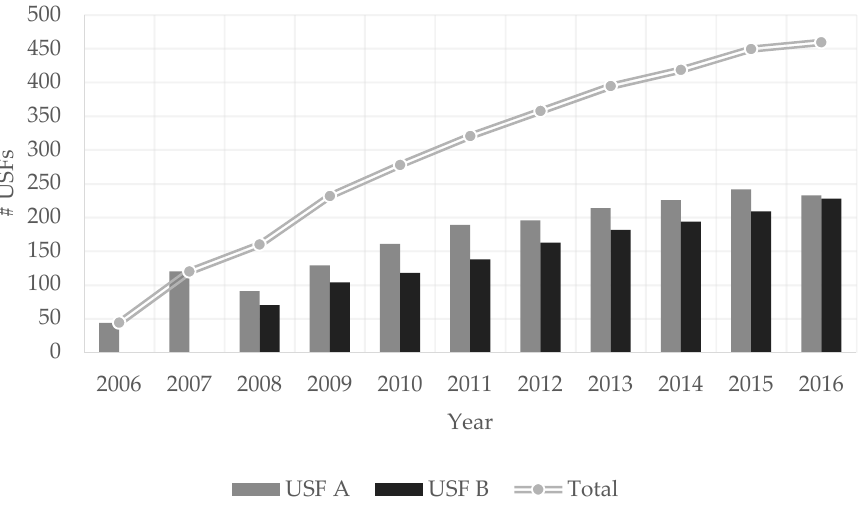
Figure 1. Evolution of the total number of USFs (2006–2016). Source: ACSS [14]. Future primary healthcare reforms plan on adding public health measures, e.g., em- bed dental medicine in the SNS, implementing countrywide cancer screening projects, providing complementary means of diagnostic to the primary healthcare’s functional units, and further developing mobile healthcare units. Some authors have pointed